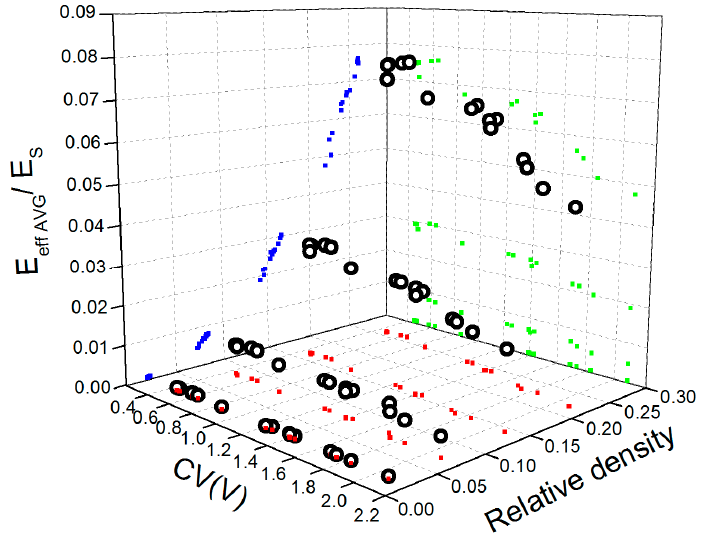
), versus relative density and (cid:35) ), and zx (